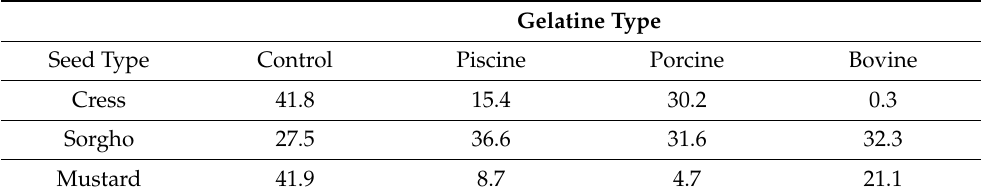
Figure 5. Effect of various bioplastics on the root length of three plants species (n = 10, error bars represent standard deviation). Table 1. Root length of seeds germinated in soil with different treatment (n =